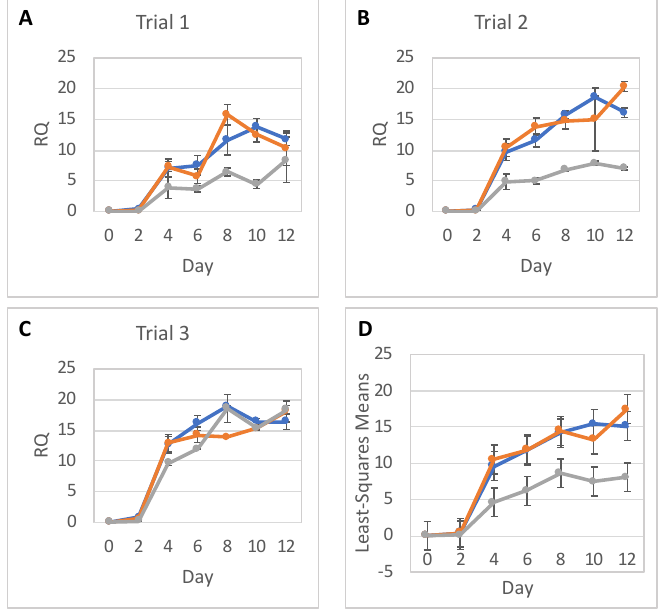
Figure 3. PAX6 gene expression. PAX6 relative to TBP RNA expression (RQ) in hESCs during their differentiation into NPCs in three independent trials ( A – C ) in 0-dose (blue), low-dose (orange), and high-dose (grey) samples; error bars show standard deviations of experimental measurements. ( D ) Statistical analysis of PAX6 expression data; error bars show 95% confidence limits for the least square means of PAX6 RQs in 0-dose (blue), low-dose (orange), and high-dose (grey) samples from all trials and with replicates combined. Table 1. Difference between 0-dose and low-dose groups in least square means of PAX6 RNA expression according to day.